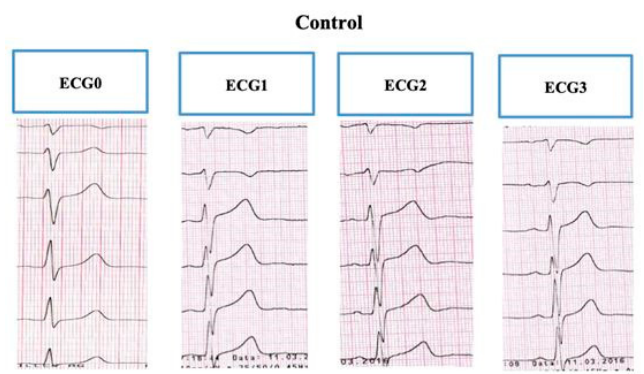
Figure 2. The sample electrocardiogram of a child with vasovagal syncope with T-waves normal morphology recorded on admission to the ward and in the three phases of the tilt test: in all electrocardiogram recordings, T-waves did not change after verticalization. Source: the medical documentation of a child with vasovagal syncope, hospitalized at the Children’s Cardiology Clinic. The control group showed normal T-wave morphology in all ECG recordings (Figure 3).